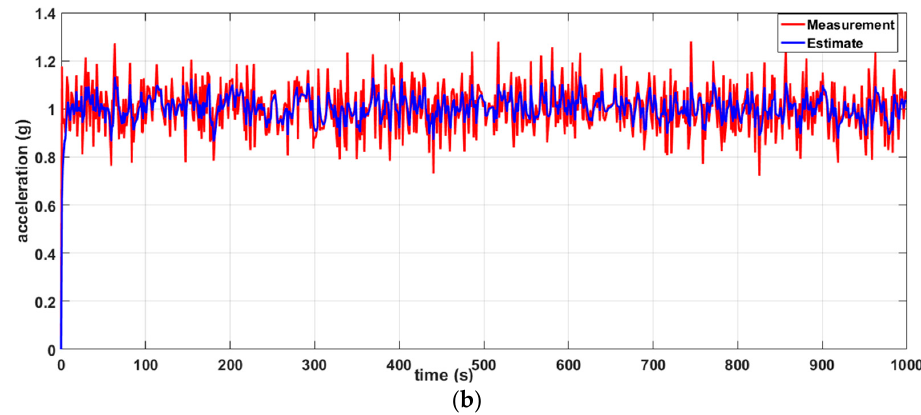
Figure 7. Results of simulation the distributed Kalman algorithm: ( a ) two-node linear Wireless Sensor Network (WSN); ( b ) three-node linear WSN.